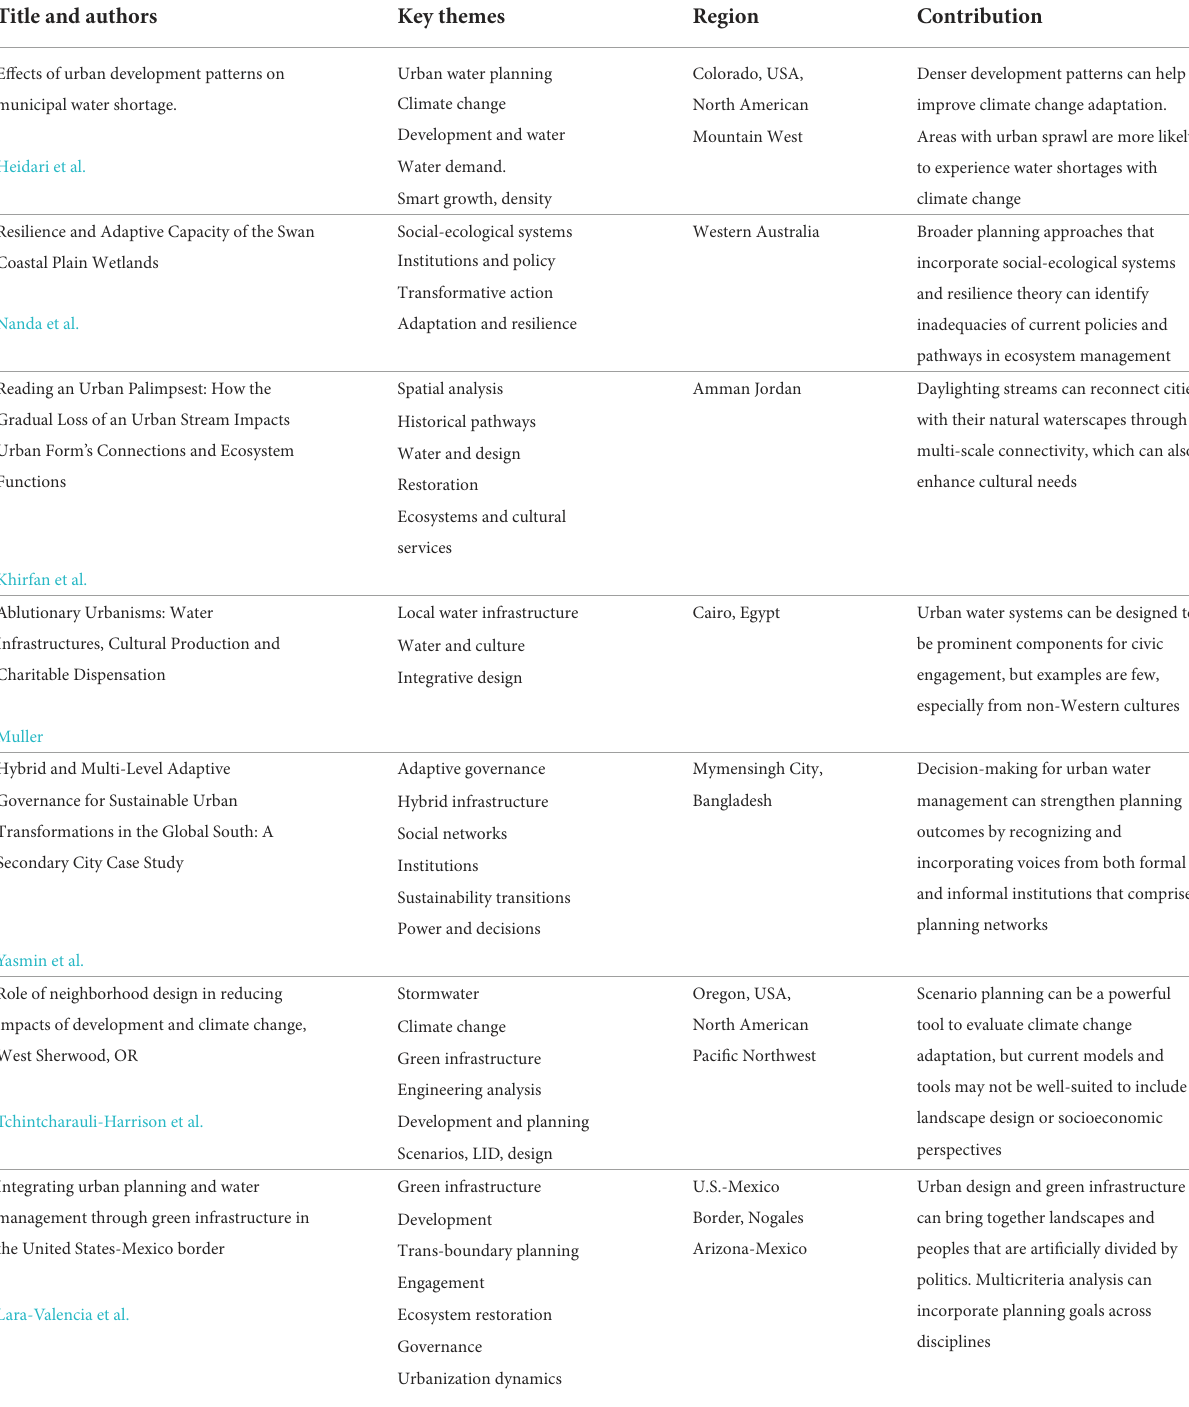
TABLE 1 Summary of contributions to the Research Topic on Urban Water Management, Planning and Design